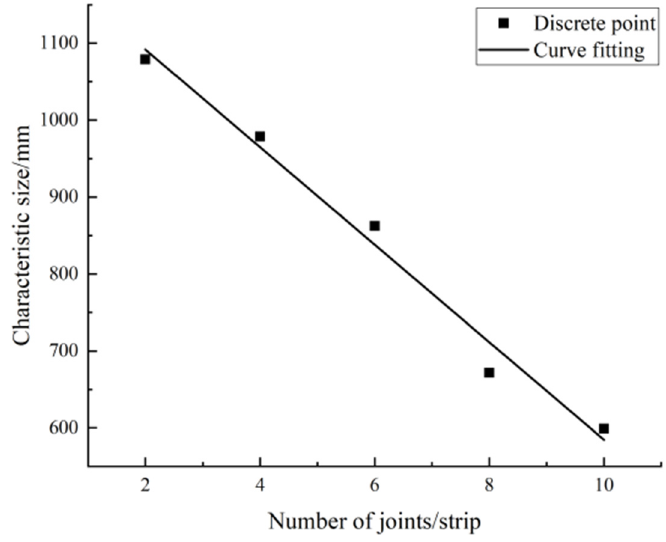
Figure 13. Fitting curve between the characteristic size and NPJ.